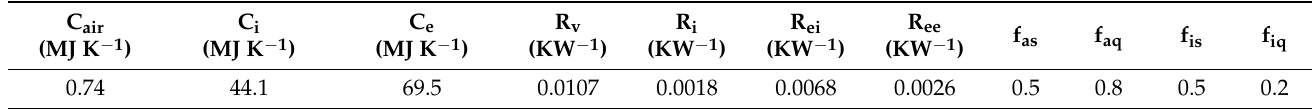
Table 2. RC thermal network parameters.